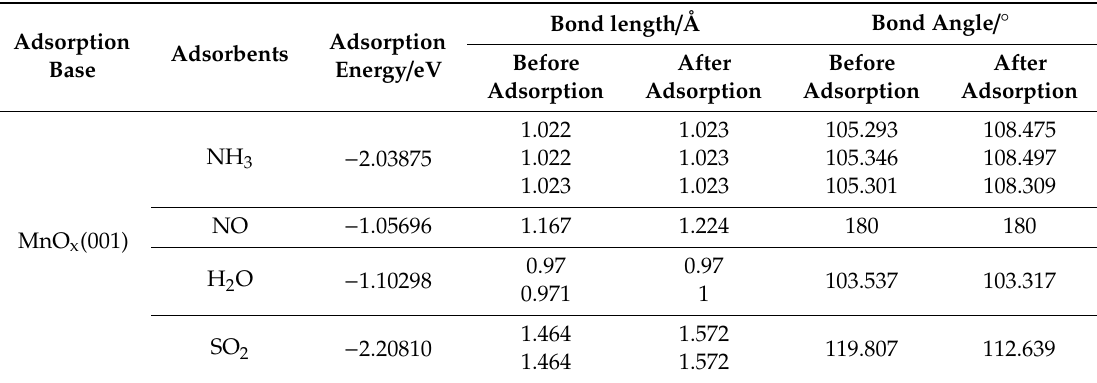
Table 1. Adsorption structure and adsorption